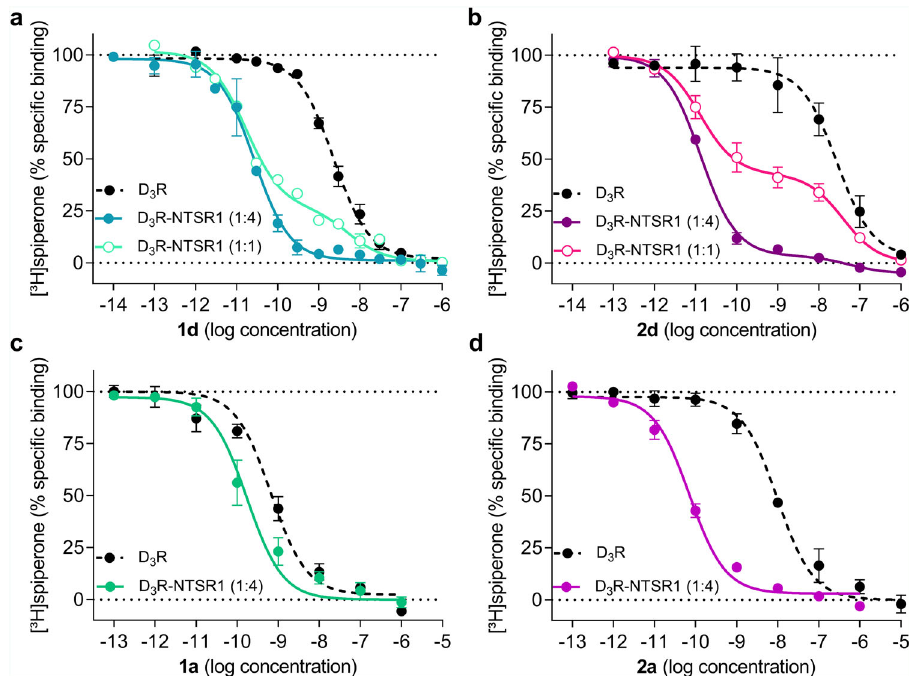
Fig. 2 D 3 R Binding behaviour of bivalent ligands. Competition binding experiments were carried out with [³H]spiperone and membranes from HEK293T cells either monoexpressing D 3 R or coexpressing D 3 R and NTSR1. Bivalent ligands 1d ( a ) and 2d ( b ) comprising the long 88-atom spacer or 1a ( c ) and 2a ( d ) comprising the short 22-atom spacer bind to D 3 R with binding af fi nities in the high picomolar to low nanomolar range ( n = 4 for 1d and n = 3 for 1a , 2a , 2d ). Coexpression of an excess of NTSR1 (relative stoichiometry D 3 R to NTSR1 1:4) results in a 5.5- to 1460-fold increase in af fi nity ( n = 4 for 1a ; n = 5 for 1d , 2d and n = 3 for 2a ). Biphasic displacement curves revealing two distinct af fi nities corresponding to the high- and low-af fi nity binding mode are resolved when experiments are carried out at a 1:1 D 3 R to NTSR1 stoichiometry ( n = 3 for 1d and 2d ). Data are presented as mean ± s.e.m. of n biologically independent